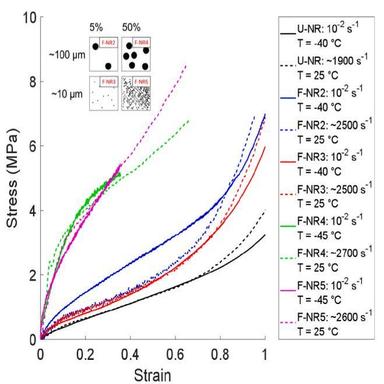
Showing that experimentally simulating the high rate response of all grades of NR is possible with the use of low temperature quasi-static analogue experiments.